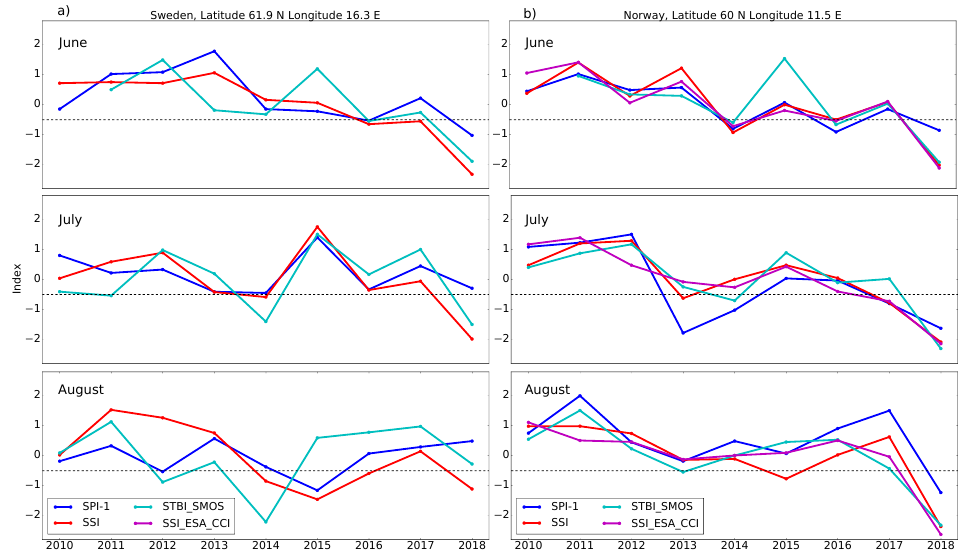
Figure 2. ( a ) Time-series of the SPI-1 (blue), STBI_SMOS (cyan) and SSI_LDAS (red) over a grid-cell in Sweden (61.9 ◦ N and 16.3 ◦ E) from 2010 until 2018 for the boreal summer months June, July and August. The horizontal black dotted line indicate D0 drought conditions, see text for further explanation. Please note that for this region there were no observations for the computation of the SSI_ESA_CCI. ( b ) Same as a) but for a grid-cell in Norway (60.0 ◦ N and 11.5 ◦ E), here observations from the ESA CCI were available for the computation of the SSI_ESA_CCI drought index. For the different indices the grid-cell sizes are: 0.36 ◦ for the STBI_SMOS and 0.25 ◦ for the SPI-1, SSI_LDAS and